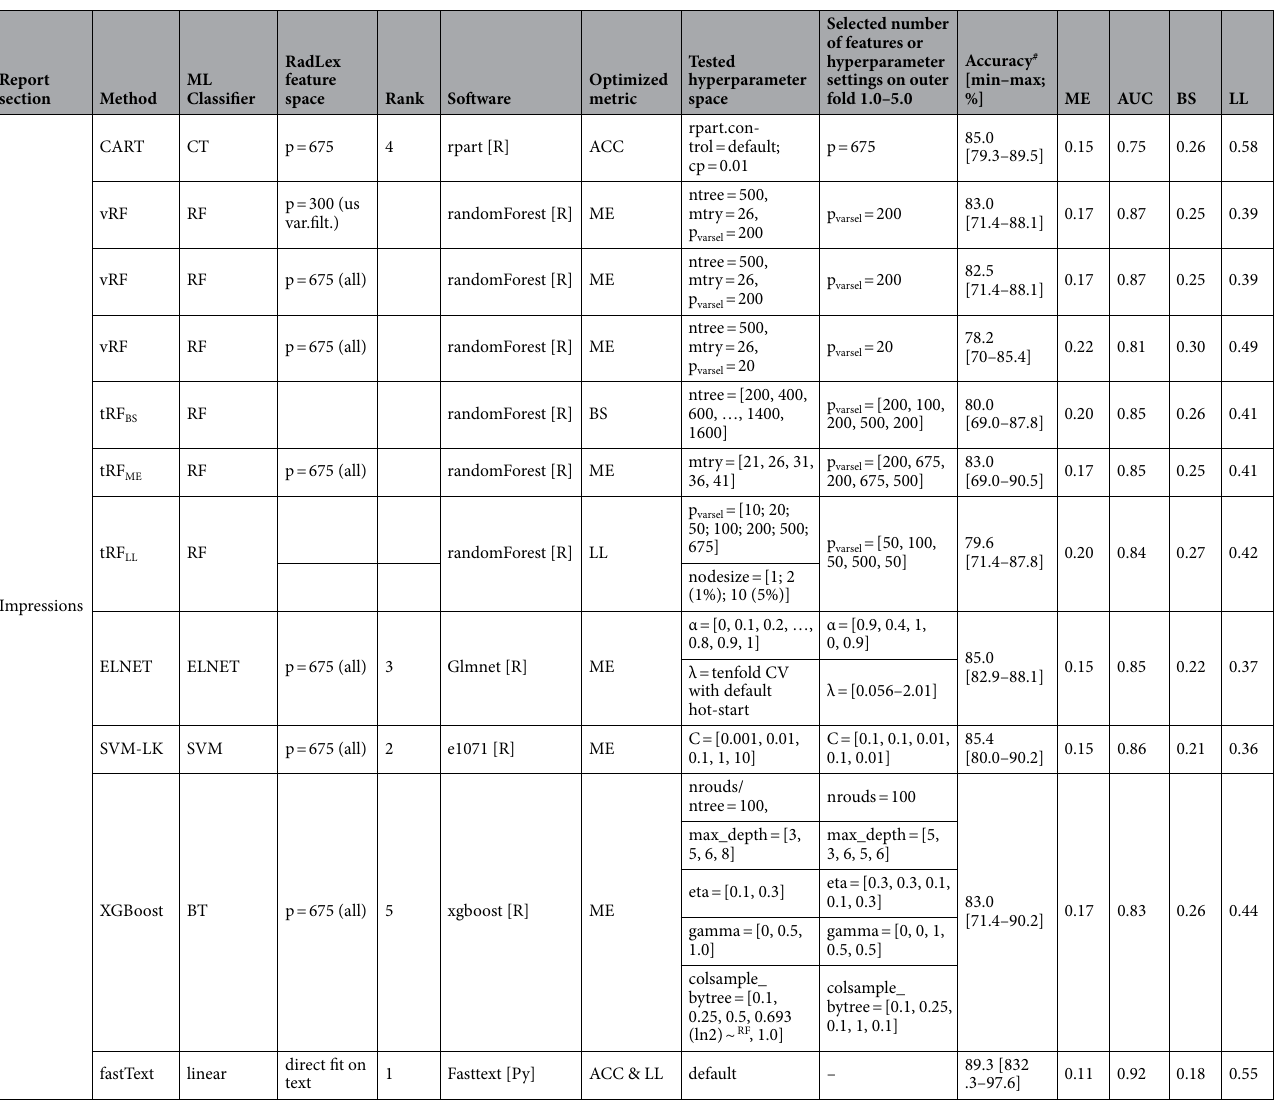
Table 2. Summary table of performance measures of the investigated ML algorithms on the NLP-annotated bag-of-RadLex features of the findings and impressions sections. Accuracy#: the averaged fivefold CV accuracy is calculated, ACC: accuracy, AUC: multiclass area under the ROC after Hand and Till (that can only be calculated if probabilities are scaled to 1), us var.filt: unsupervised variance filtering using p = 300 most variable RadLex terms -this step was previous of training to prevent information leakage, BS: Brier score, ME: misclassification error, LL: multiclass log loss, vRF and tRF: vanilla- and tuned random forests, ELNET: elastic net penalized multinomial logistic regression, SVM: support vector machines, LK: linear kernel SVM; XGBoost: extreme gradient boosting using trees as base learners, BT: boosted trees, CART: classification and regression trees; CT: classification tree; cp: complexity parameter used for CART node splitting (for this no optimization (pruning) was performed); ln(2) ~ RF : column sampling (i.e. bootstrap) representing the